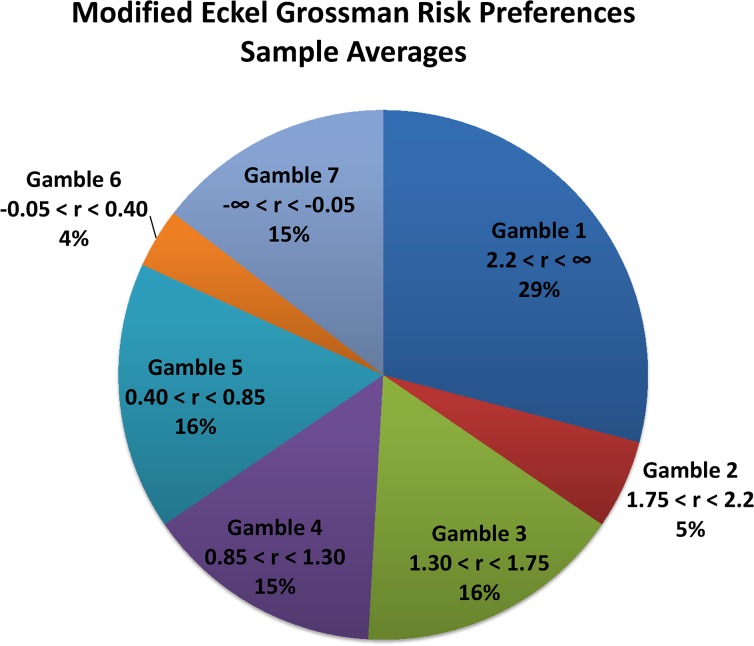
The figure reflects the proportion of participants falling into each risk preference interval from Table 1, based off of their Eckel Grossman risk task choice.